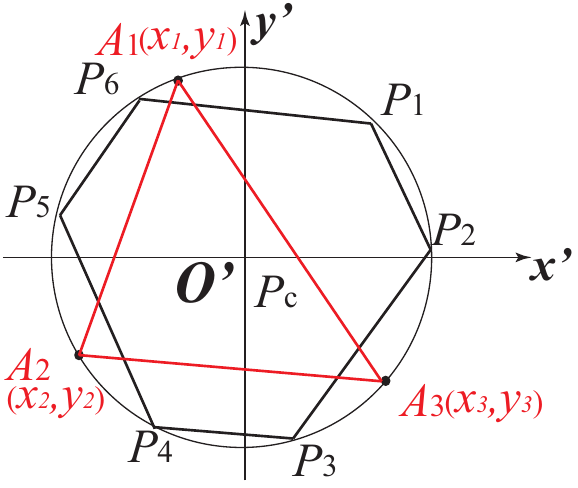
Figure 4. Discrete model composed of three points for image moment visual servoing. In the model for estimating the robot platform configuration based on the image features m = [ x g y g a α c 1 c 2 ] T , the coordinates of the three points ( A 1 , A 2 , A 3 ) (Figure 4) are involved, as well as the camera pose. The value of these parameters will be optimized later during the design optimization